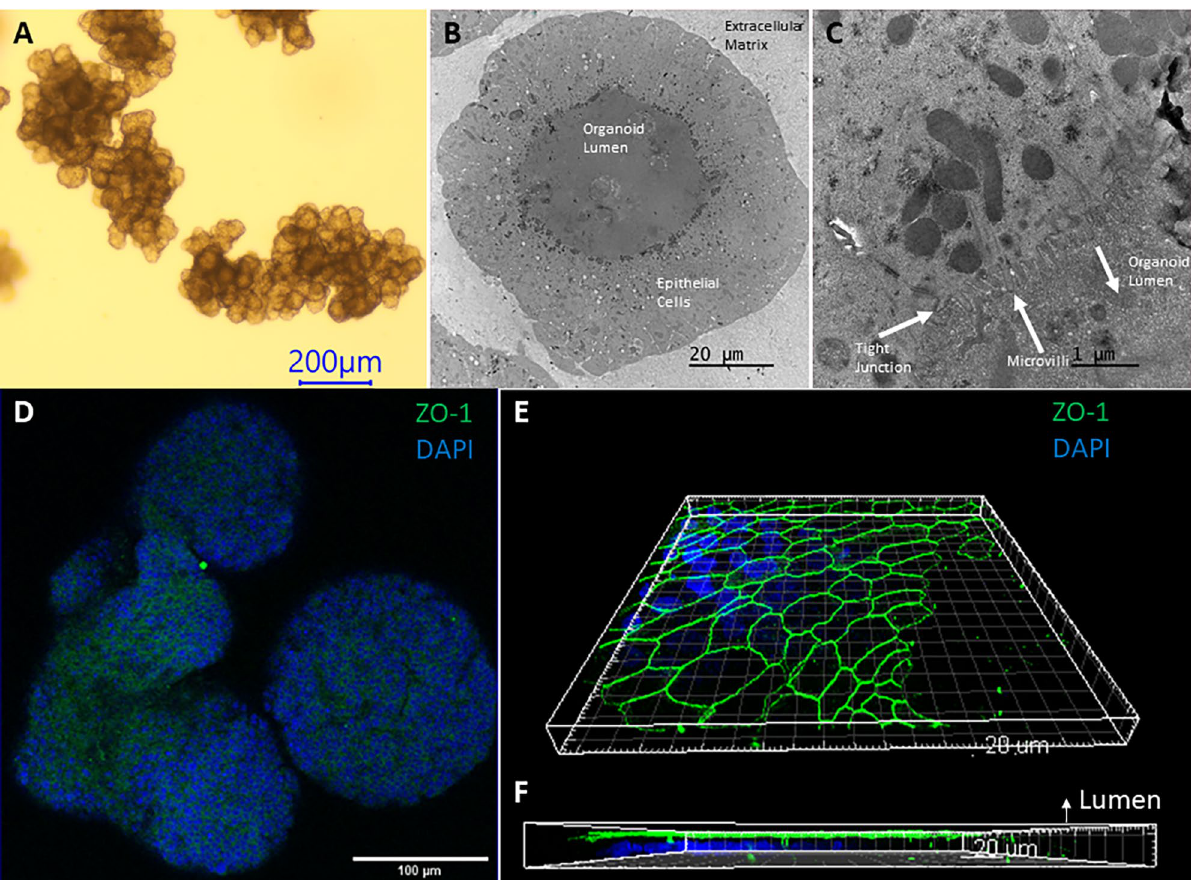
Figure 1. Bovine intestinal organoid characterization ( A ) Brightfield image of a bovine enteroid using a ×4 objective lens. Scale bar denotes 200 µm. ( B,C ) Transmission electron microscopy images of a bovine enteroid with annotated microvilli, tight junction, and lumen. ( D ) Whole mount Immunocytochemical imaging of ZO-1 (Alexa Fluor 488) and DAPI using a ×20 objective lens ( E,F ) 3D modeling (Imaris Image Software) of ZO-1 (Alexa Fluor 488) and DAPI staining using stacked confocal images taken with a ×100 objective lens, with annotated lumen, displaying the apical border of an treated with 100 ng/mL of TNFα or IFNγ displayed an increased darkening of the enclosed lumen, and enteroids treated with IFNγ also displayed irregular and ruffled basolateral margins. These morphological changes suggest an increased rate of dead cell accumulation within the enteroid lumen.